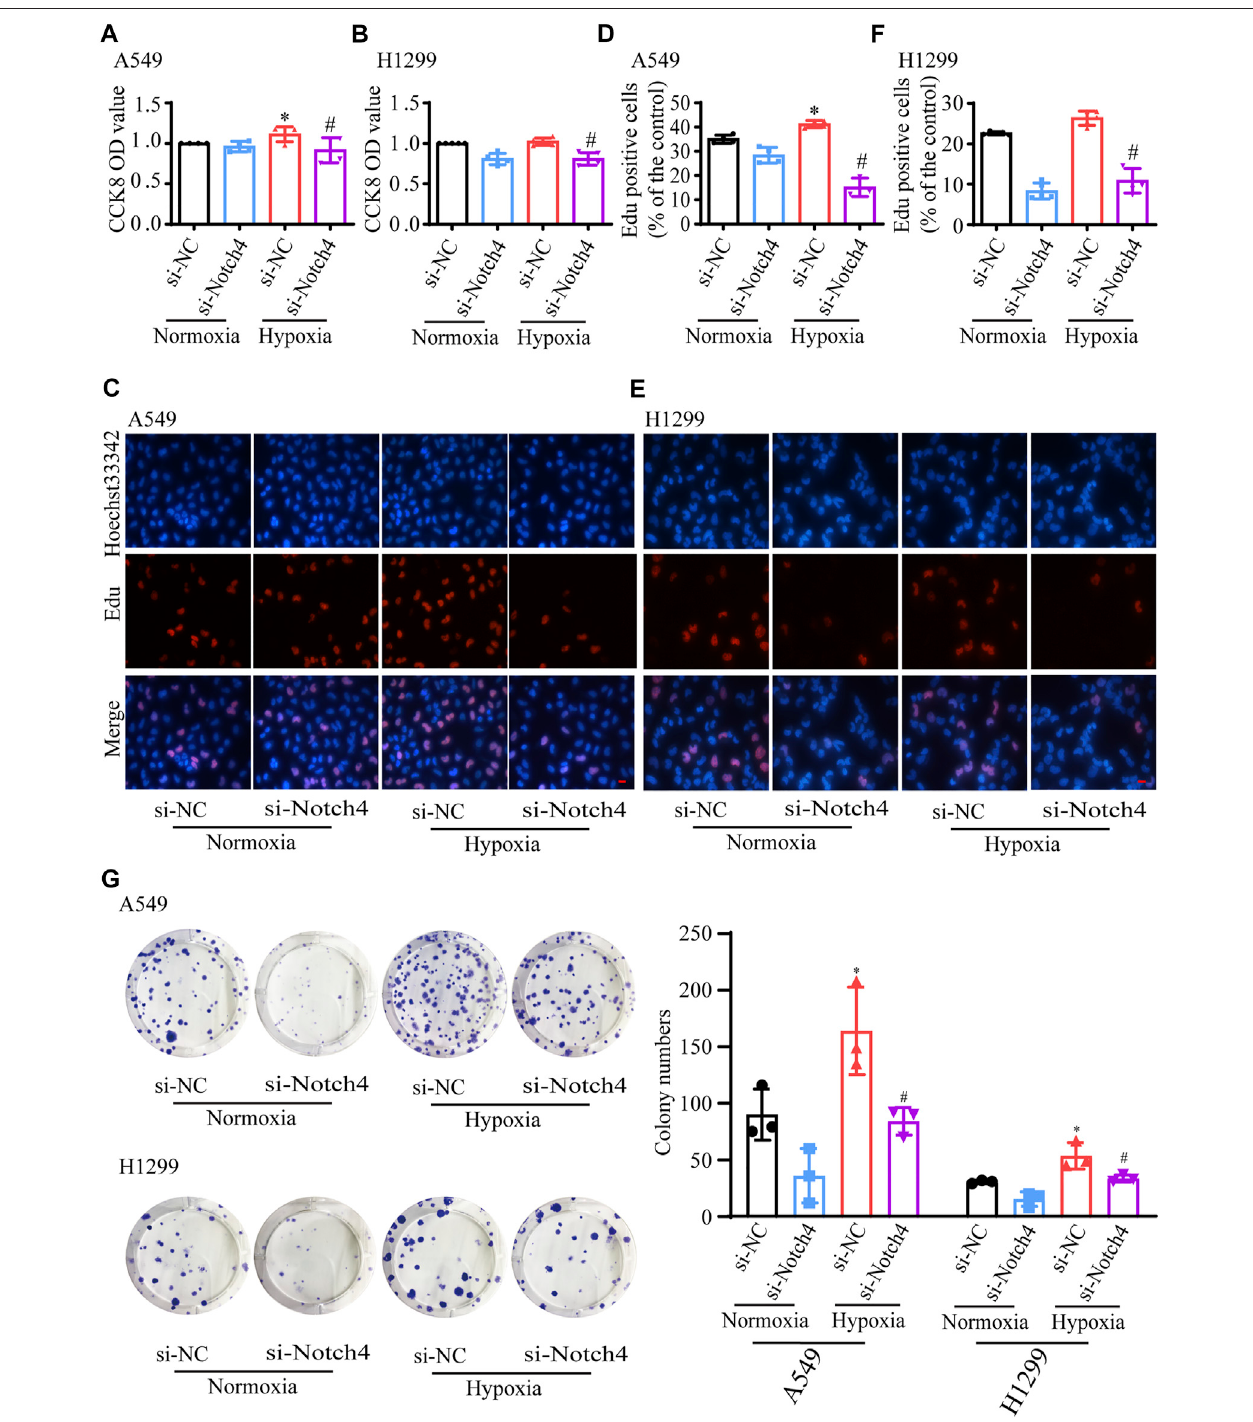
FIGURE 3 | Notch4 is involved in the regulation of cell proliferation in A549 and H1299 cells exposed to hypoxia. (A, B) Cell viability was assessed using CCK-8 assay in A549 and H1299 cells ( n (cid:2) 4 – 5). (C, D) A549 cell proliferation was assessed using Edu assay. ( n (cid:2) 4). Magni fi cation, × 400; Bar, 20 μ m. (E, F) H1299 cell proliferation was assessed using Edu assay. ( n (cid:2) 5). Magni fi cation, × 400; Bar, 20 μ m. (G) Colony formationassay was performed inA549 and H1299 cells. ( n (cid:2) 3). Data werepresentedasmeans ± SD.* p < 0.05,comparisonwithnormoxiccellstreatedwithsi-NC; # p < 0.05,comparisonwithhypoxiccellstreatedwithsi-NC.CCK-8, Cell Counting Kit-8; si-NC, negative control short interfering RNAs (siRNA); si-Notch4, the siRNA against Notch4.